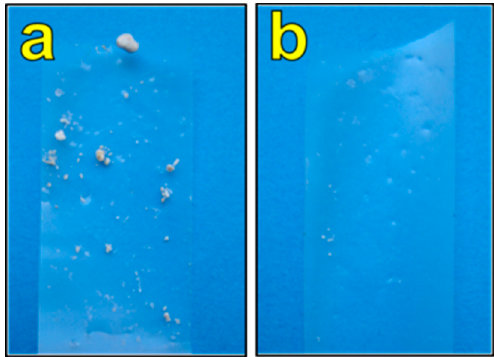
Figure 8. Scotch tape in the adhesion test for ( a ) untreated stone and ( b ) UCA-TS + F treated stone.